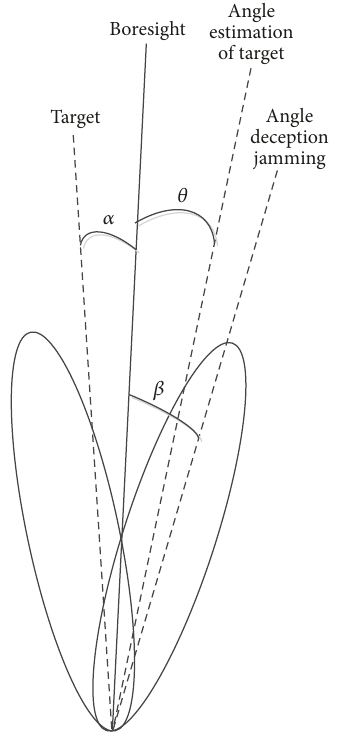
Figure 1: Schematic diagram of angle